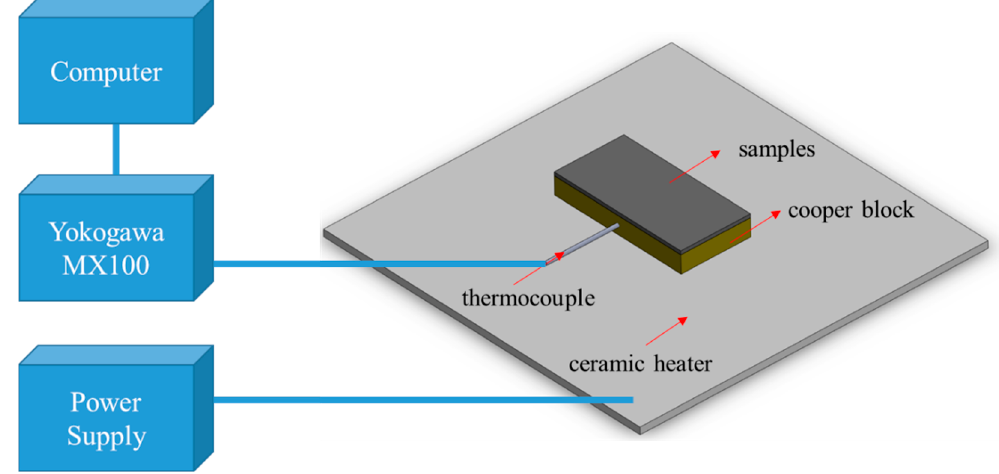
Figure 3. Experimental setup of heat dissipation measurement for different samples.